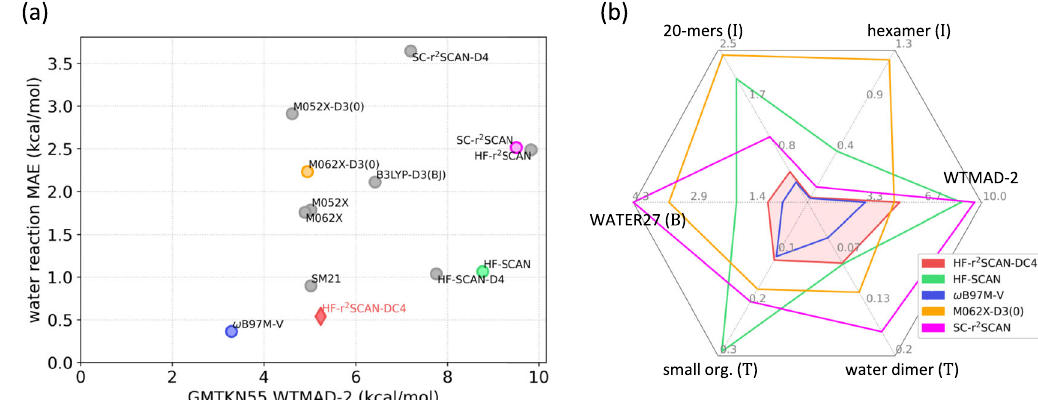
Fig. 5 | Performance of HF-r 2 SCAN-DC4 and other conventional functionals. a Themeanabsolute error(MAE)forthewater-based reactionsappearinthiswork (hexamer isomer energies, water 20-mers isomer energies, WATER27 binding energies, water-small organic molecule interaction energies, and water dimer interaction energies) versus the weighted-mean-absolute-deviation-2 (WTMAD-2) fortheGMTKN55databaseforselectedfunctionals.Forafurtherdescriptionofthe reactions used in the y -axis, see Supplementary Note 8. HF-SCAN-D4 functional